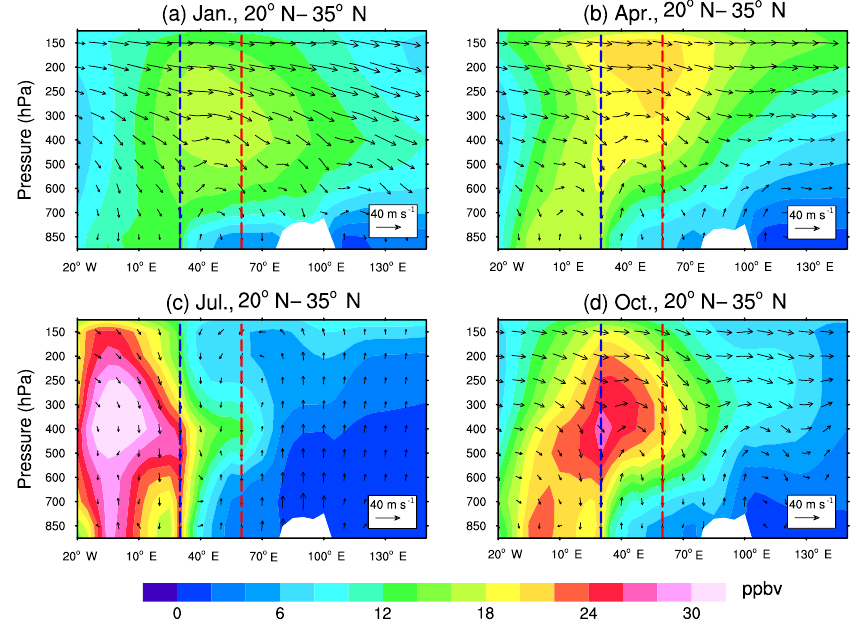
Figure 12. Longitude–altitude distribution of African ozone (in ppbv, in color), overlaid with winds (shown by arrows), in (a) January, (b) April, (c) July, and (d) October. The ozone values are the means over 20–35 ◦ N (see Fig. 10) from the 20-year GEOS-Chem simulation. White areas indicate topography. The red and blue dashed lines indicate the western border of Asia and eastern border of Africa, respectively. The vertical velocities in the p coordinates are enlarged by 200 times for illustration